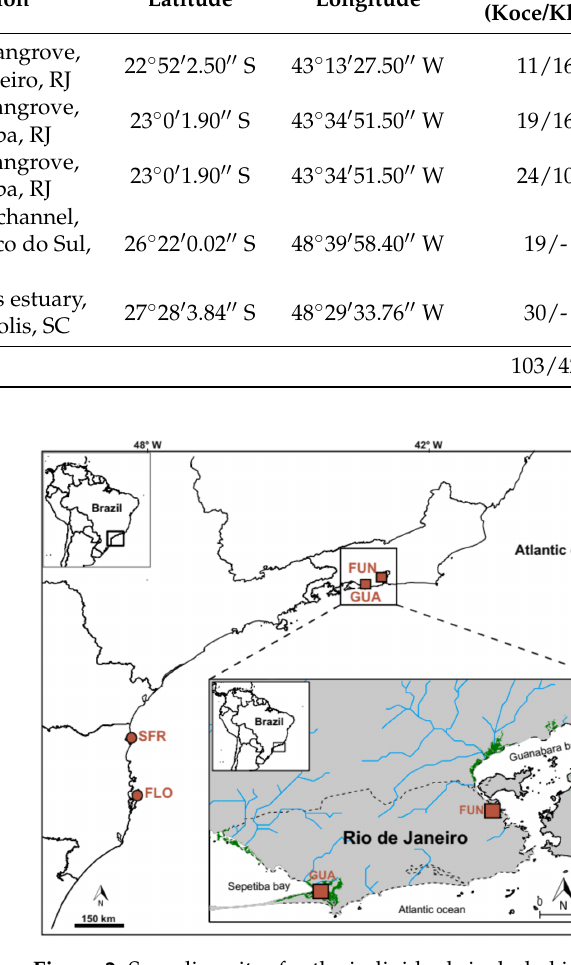
Figure 2. Sampling sites for the individuals included in the genetic analysis. Site names and details included in Table 1. Brown squares represent syntopic populations of Kryptolebias ocellatus and K . hermaphroditus and circles represent populations where only K . ocellatus was found. ( a ) Detailed map of the Rio de Janeiro municipality and its surrounding bays and